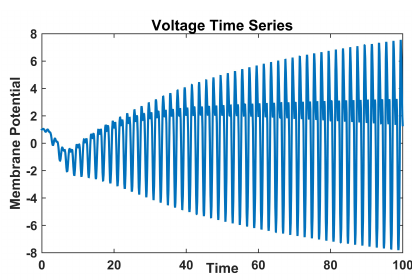
Figure 25. Responses of membrane potential with parameter values a = 0.7, b = 0.8, c = 3